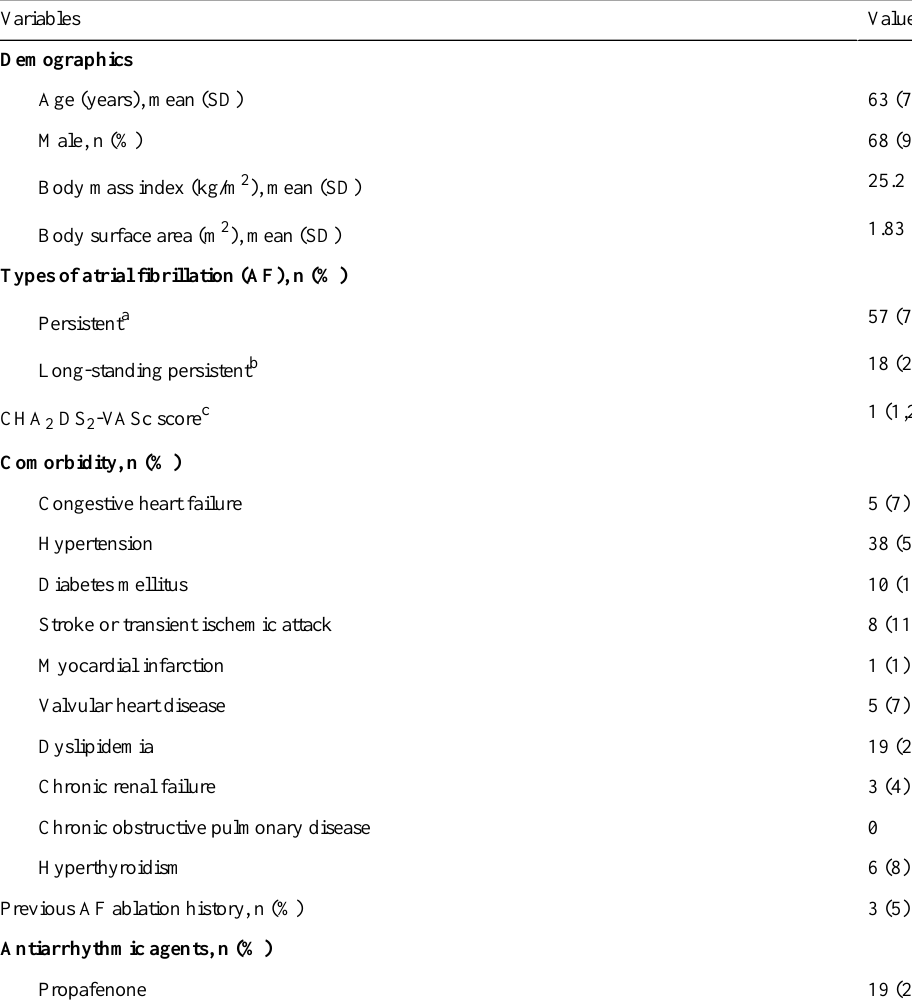
Table 1. The clinical characteristics of the study population